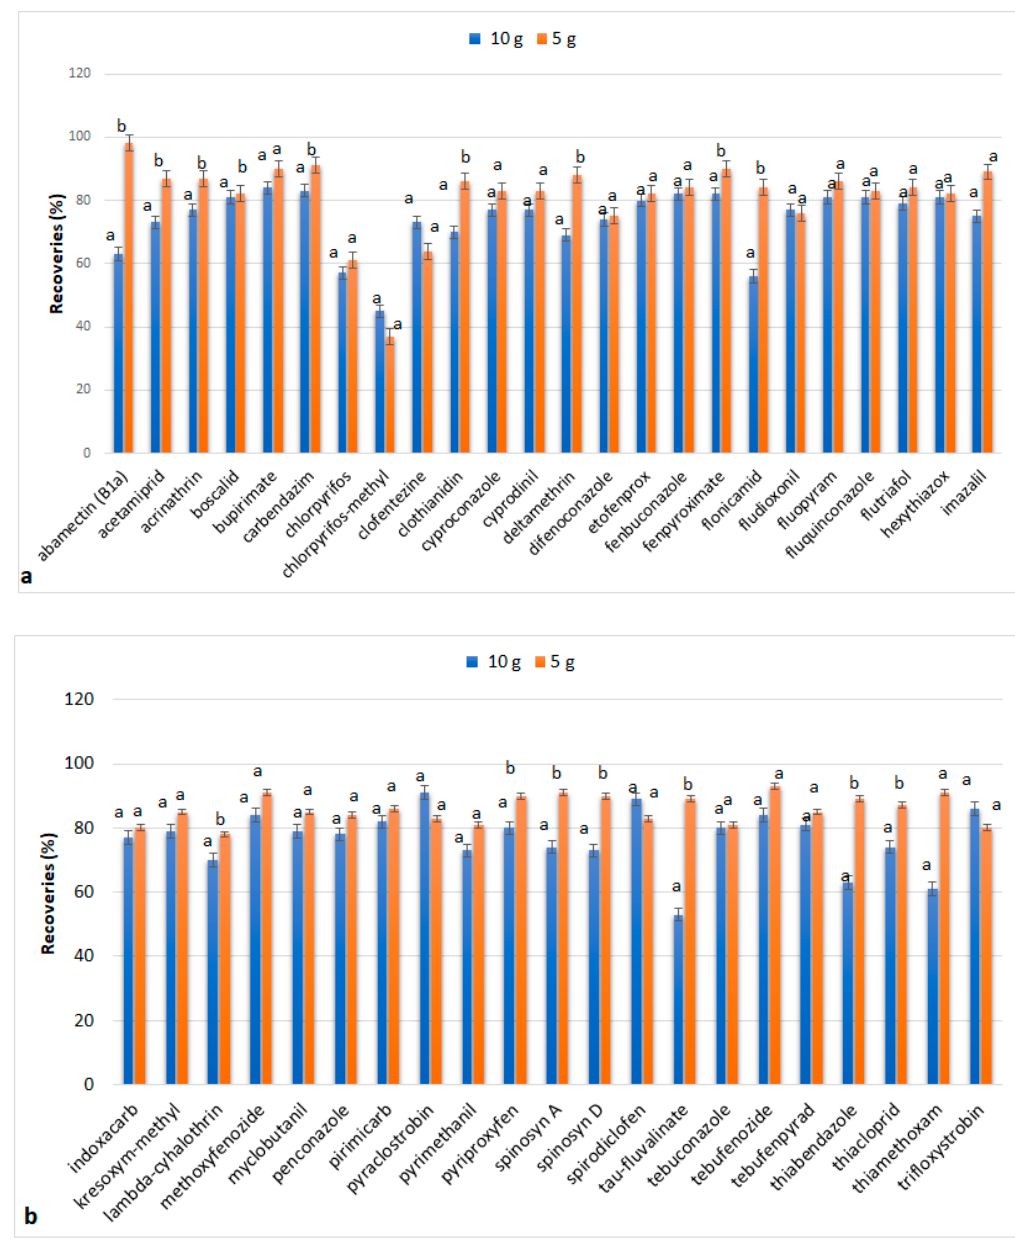
Figure 3. Recoveries (%) of analytes when MAE extraction was performed on 10 g and 5 g of tissue: ( a ) abamectin (B1a), acetamiprid, acrimathrin, boscalid, bupirimate, carbendazim, chlorpyrifos, chlorpyrifos-methyl, clofentezine, clothianidin, cyproconazole, cyprodinil, deltamethrin, difenoconazole, etofenprox, fenbuconazole, fenpyroximate, flonicamid, fludioxonil, fluopyram, fluquinconazole, flutriafol, hexythiazox, imazalil; ( b ) indoxacarb, kresoxym-methyl, lambda-cyhalothrin, methoxyfenozide, myclobutanil, penconazole, primicarb, pyraclostrobin, pyrimethanil, pyriproxyfen, spinosyn A, spinosyn D, spirodiclofen, tau-fluvalinate, tebuconazole, tebufenozide, tebufenpyrad, thiabendazole, thiacloprid, thiamethoxam, trifloxystrobin, alternariol (AOH), alternariol monomethyl ether (AME). The values for each substance followed by the same letter do not differ significantly statistically ( p <